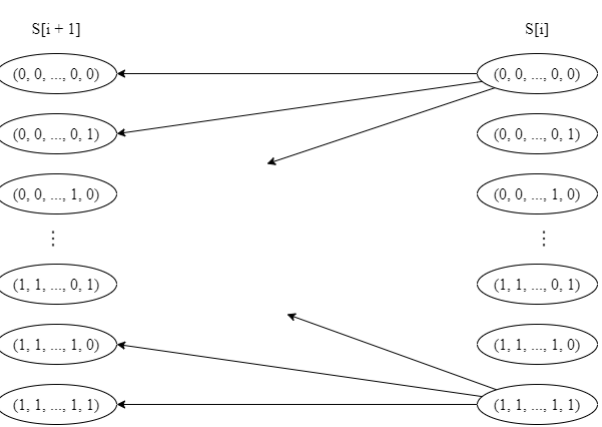
Figure 9: A bipartite graph from the